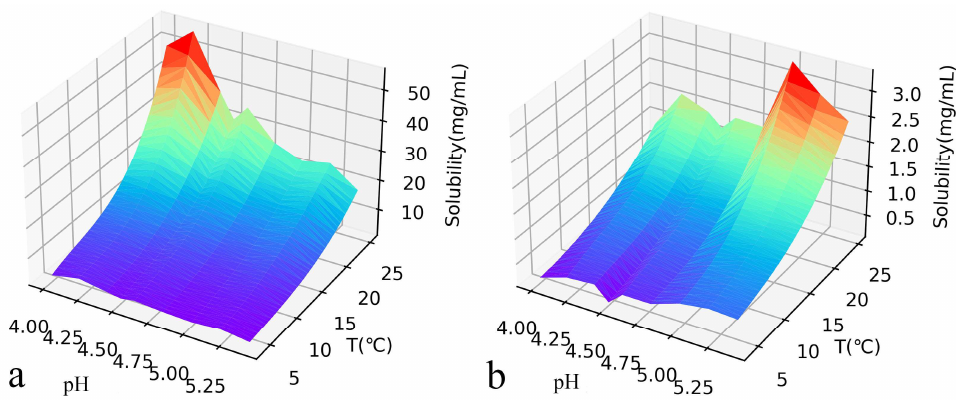
Figure 3. In a 0.1M acetic acid buffer, the concentration of NaCl 2% ( a ) and 7% ( b ), and the effect of temperature and pH value on the solubility of lysozyme. The solubility increased with the increase of temperature and decreased with the increase of salt concentration. The data source is Ref.[11].